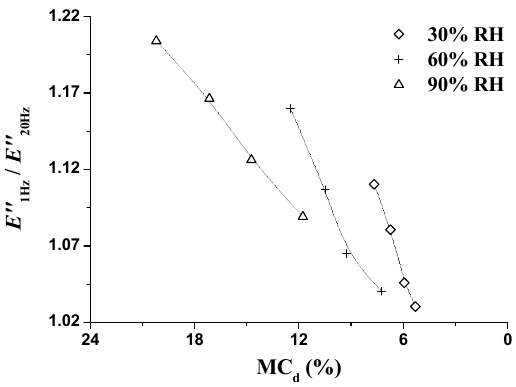
Figure 11. Changes of E ′ 1Hz / E ′ 20Hz ( a ) and E ′′ 1Hz / E ′′ 20Hz ( b ) during the RH isohume periods (30%, 60%, and 90% RH).